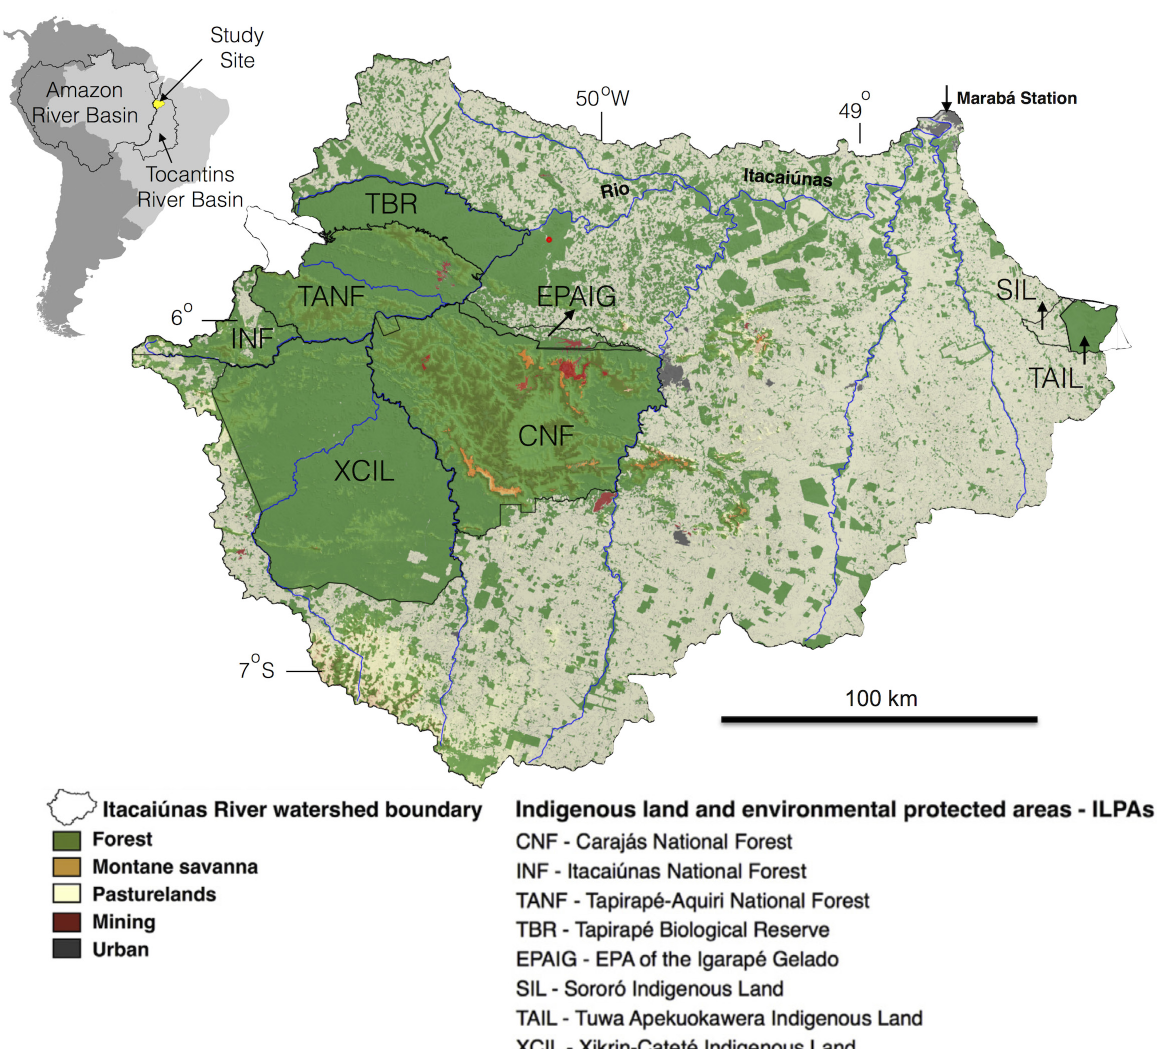
Figure 1 - Location map of the Itacaiúnas River Watershed (IRW), showing the contrast in vegetation between protected areas and areas dominated by pastures (modified from Souza-Filho et al.